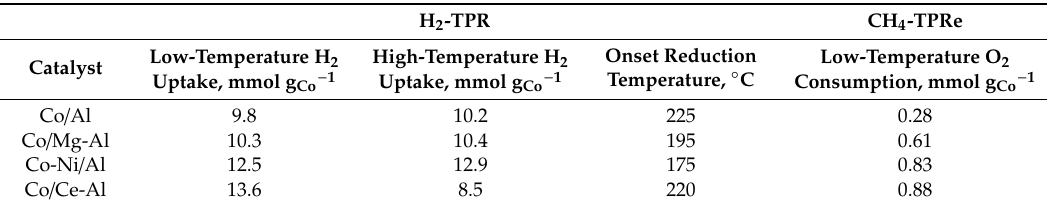
Table 3. Characterization by H 2 -TPR and temperature-programmed reaction with methane in the absence of oxygen (CH 4 -TPRe) of the supported cobalt